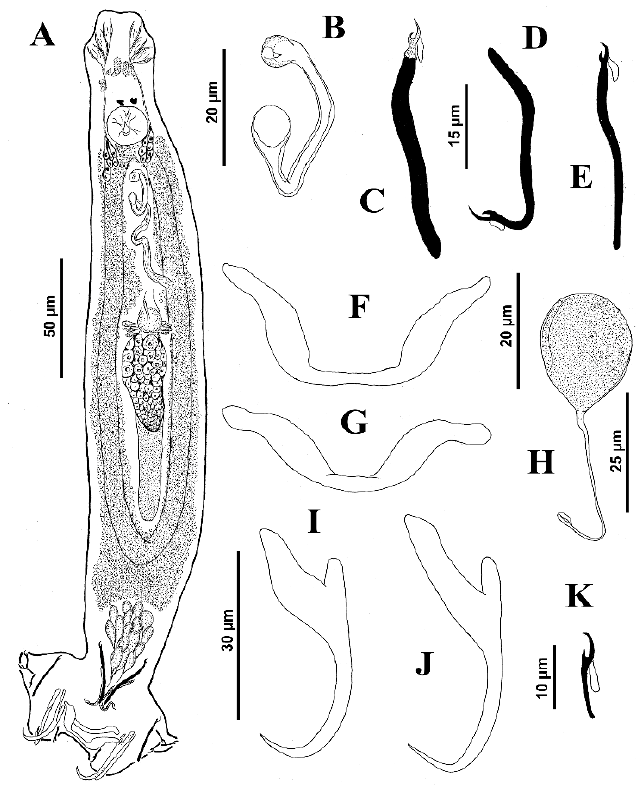
Figure 4. Neohaliotrema manubrium n. sp. from the Sergeant-major Abudefduf saxatilis ( A ) Whole mount (composite, ventral view) ( B ) Copulatory complex ( C ) Hook pair 1 ( D ) Hook pair 2 ( E ) Hook pair 3 ( F ) Ventral bar ( G ) Dorsal bar ( H ) Egg ( I ) Ventral anchor ( J ) Dorsal anchor ( K ) Hook.